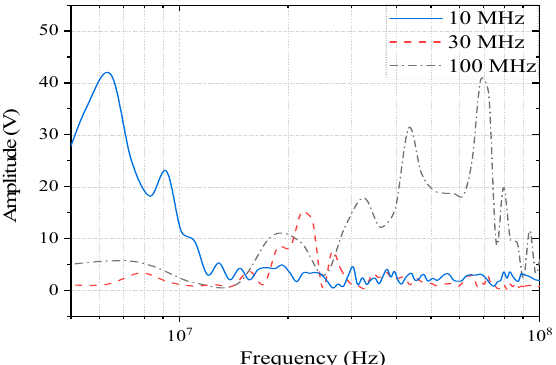
Figure 13. LVDT sensor terminal coupling voltage signal in the pulse current injection (PCI) test.